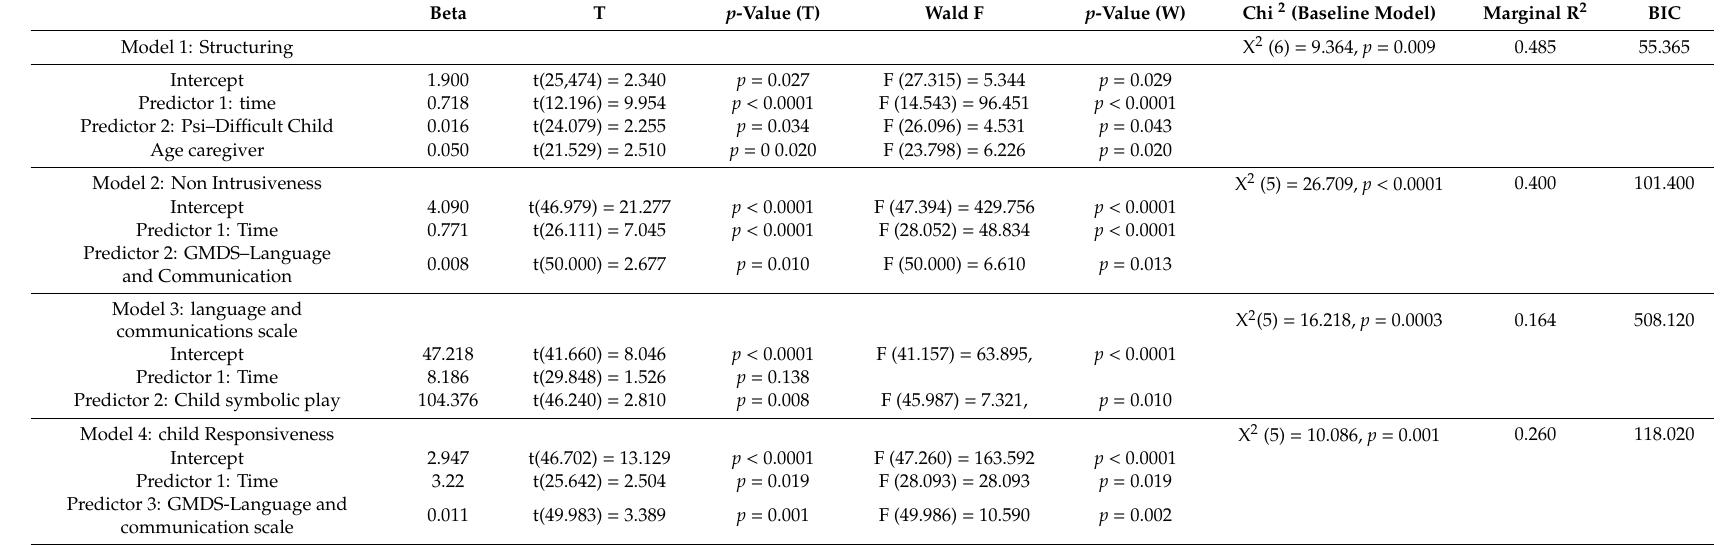
Table 7. Results of Mixed Linear